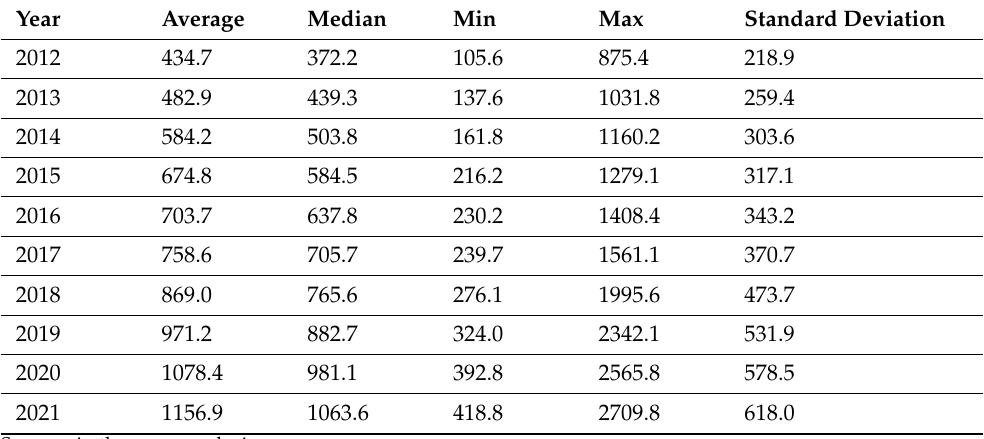
Table 3. Basic descriptive statistics for variability of bike road lengths in following years.